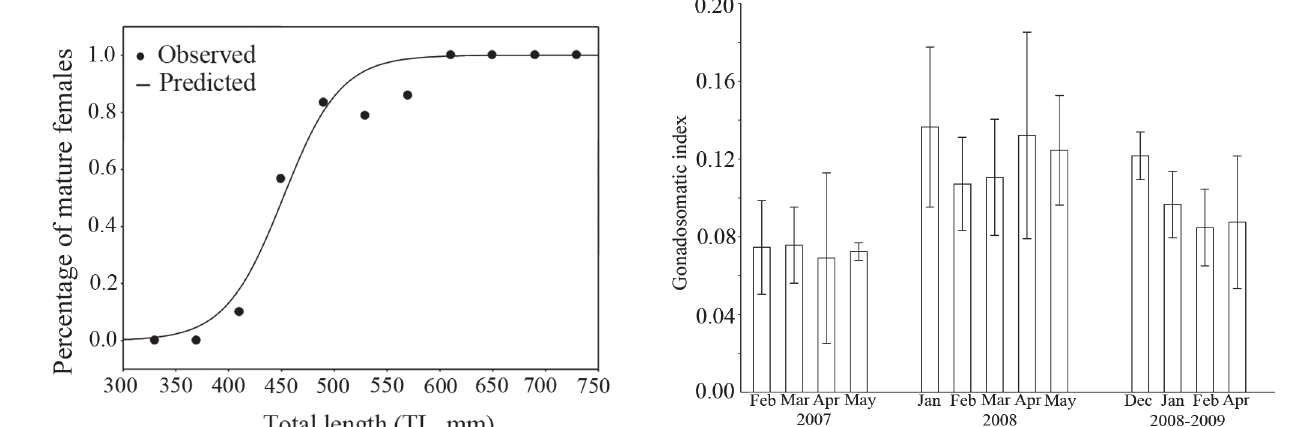
Fig. 6. Percentage of mature resting females for specimens of the dusky grouper (Mycteroperca marginata ) collected in the study area by total length classes, fitted to a logistic = 451.3 mm. n = 111. function. L 50